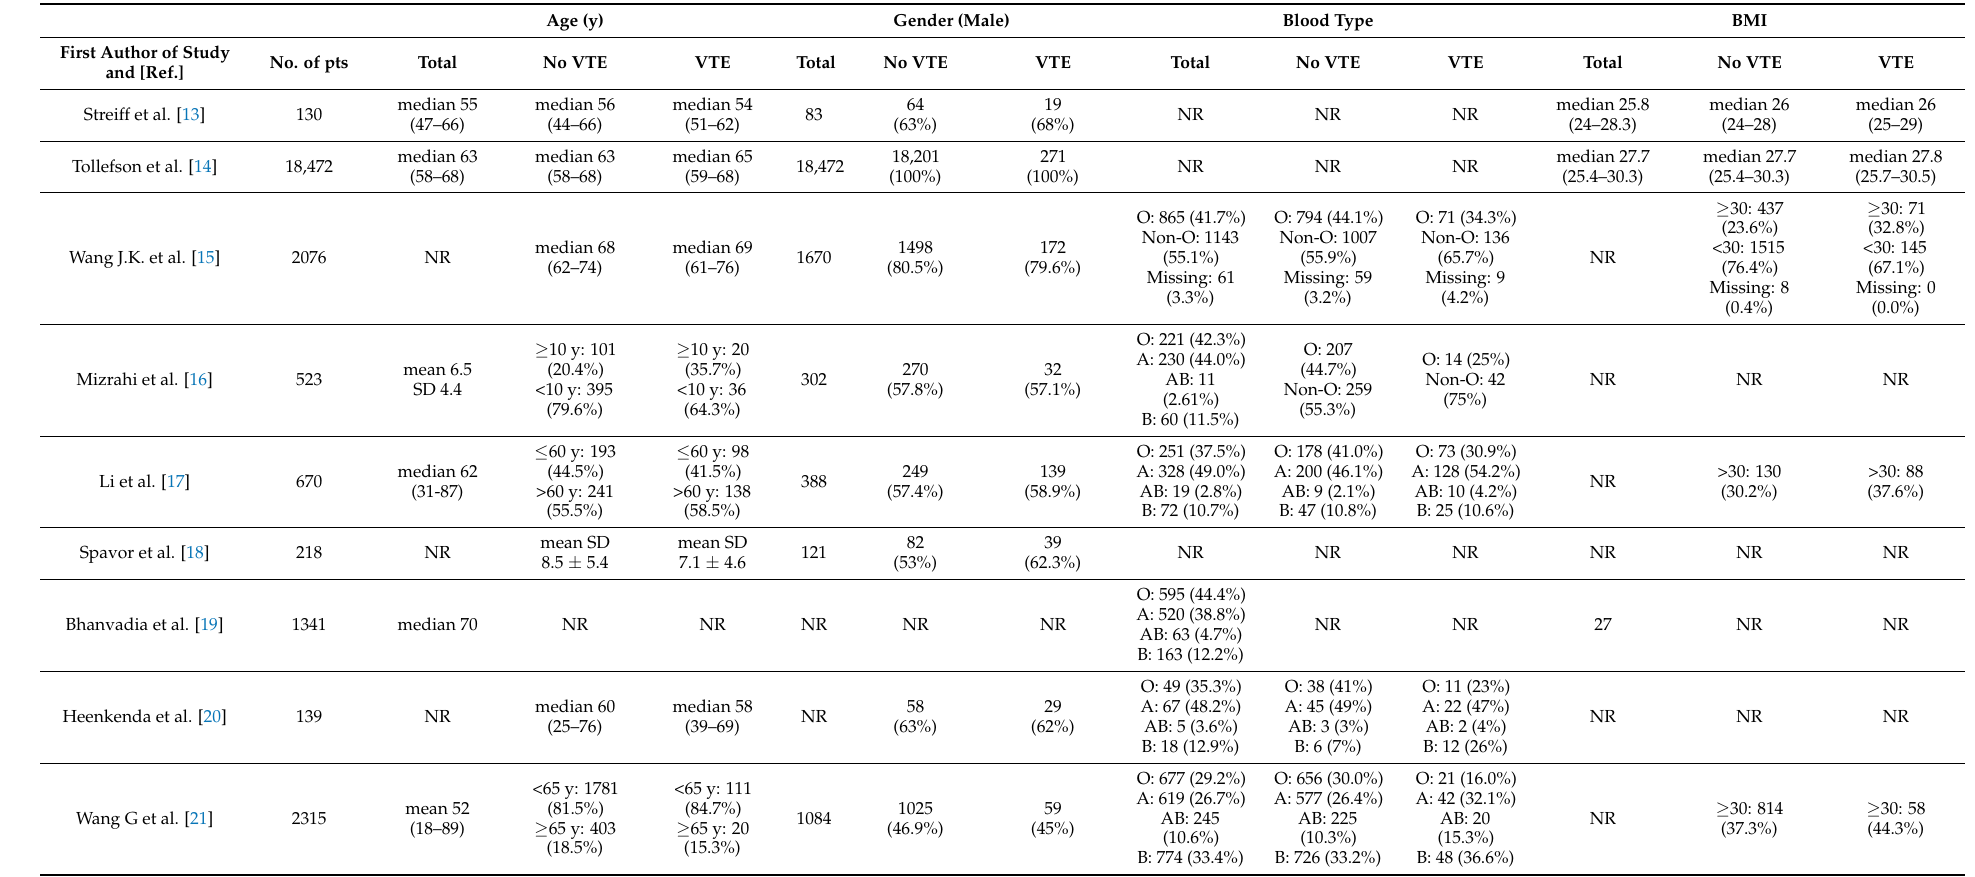
Table 2. Comparison of characteristics of patients between VTE and non